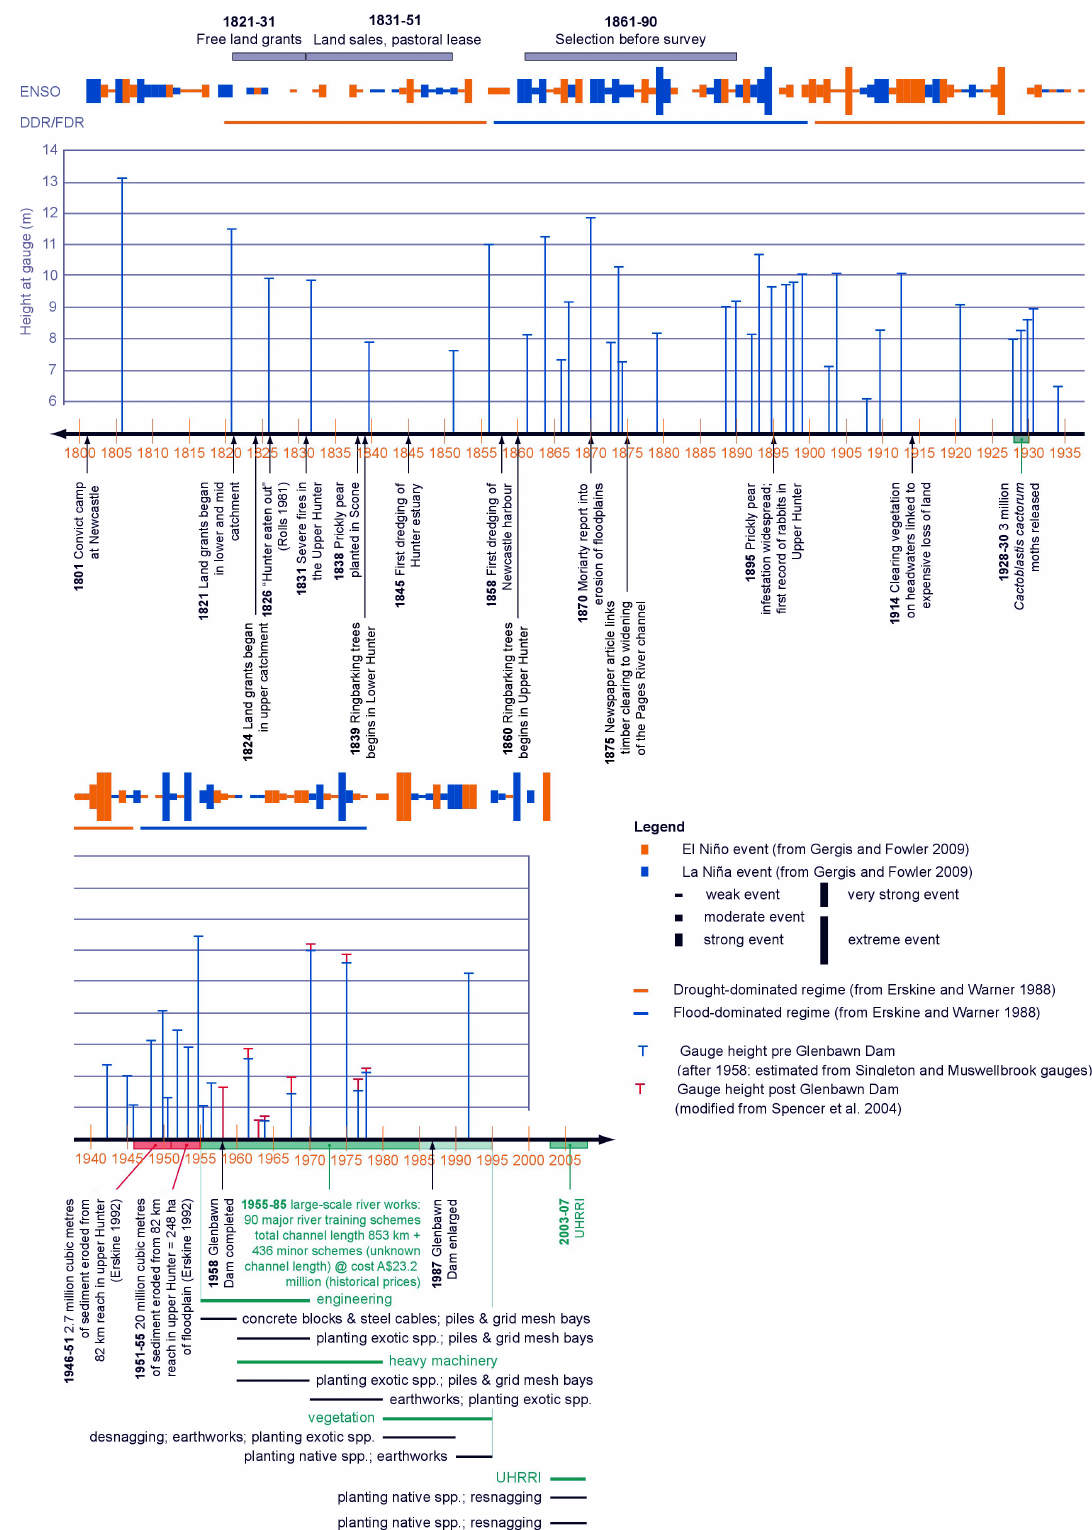
Fig. 3 . Timeline of European settlement in the Hunter